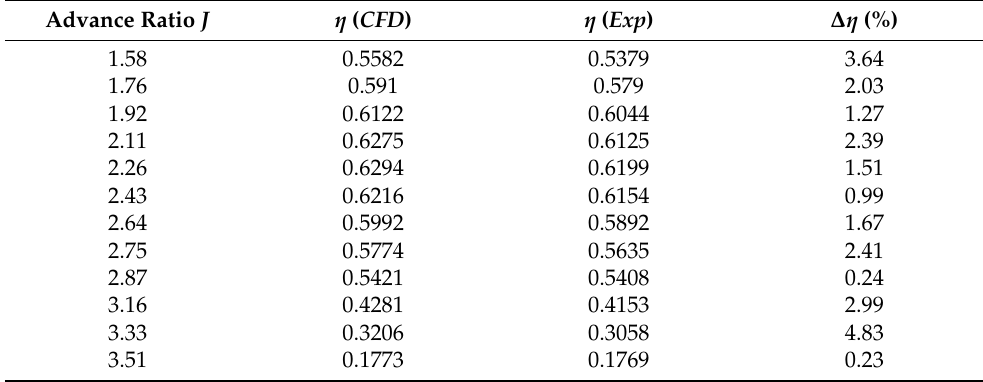
Table 5. Error between the CFD and experimental (Exp) results.